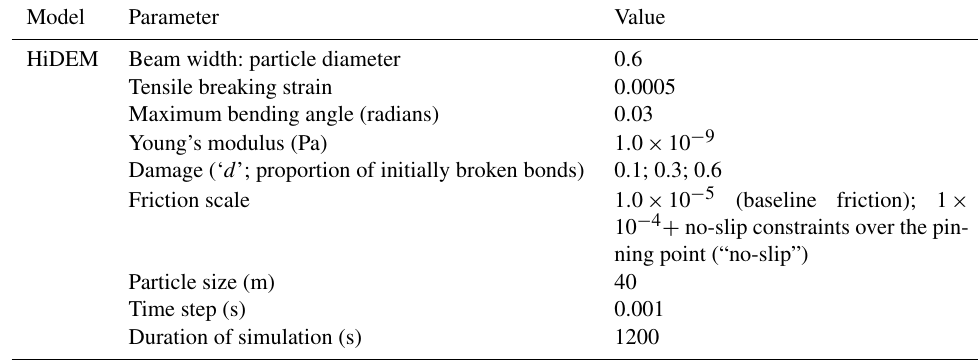
Table 1. Key parameters in simulations using the Helsinki Discrete Element Model (HiDEM). Model